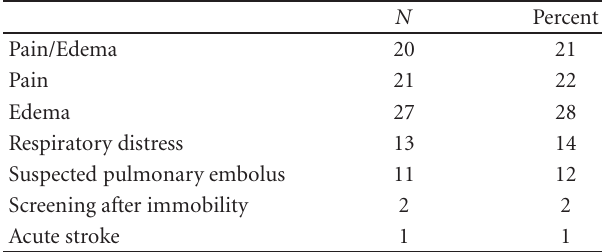
Table 1: Indications for duplex scan.